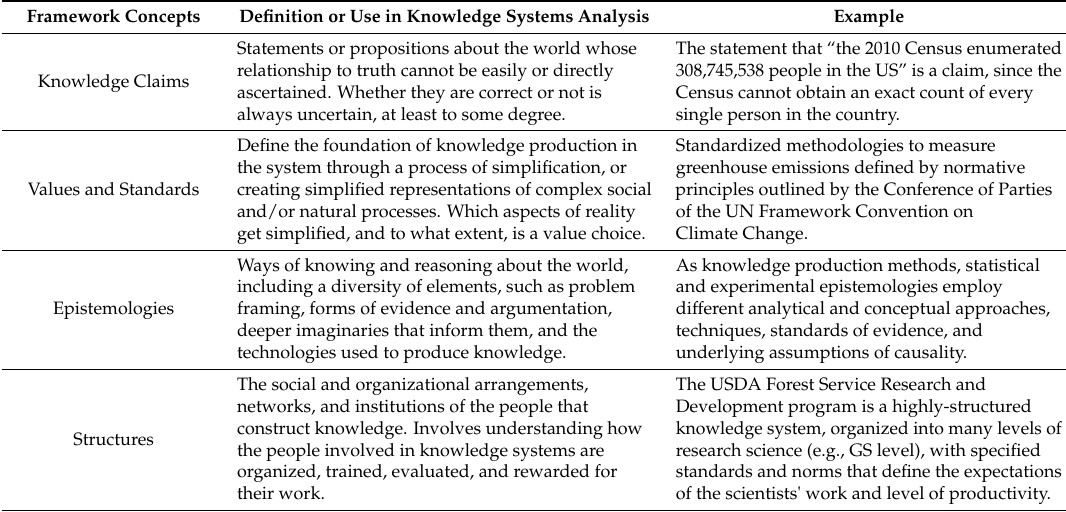
Table 1. Elements of knowledge